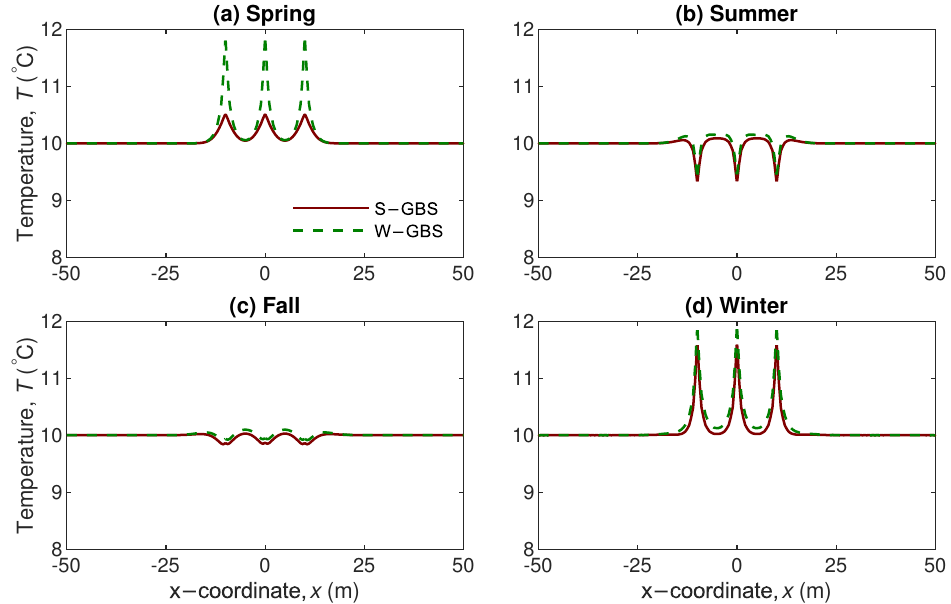
Figure 10. Temperature distribution over the x -coordinate (i.e., the line y = 0) for 3-by-3 boreholes over four seasons: ( a ) Spring ( t = 3 (mon)); ( b ) Summer ( t = 6 (mon)); ( c ) Fall ( t = 9 (mon)); and ( d ) Winter ( t = 12 (mon)). The S-GBS is given by the red solid line and the W-GBS is given by the green dashed